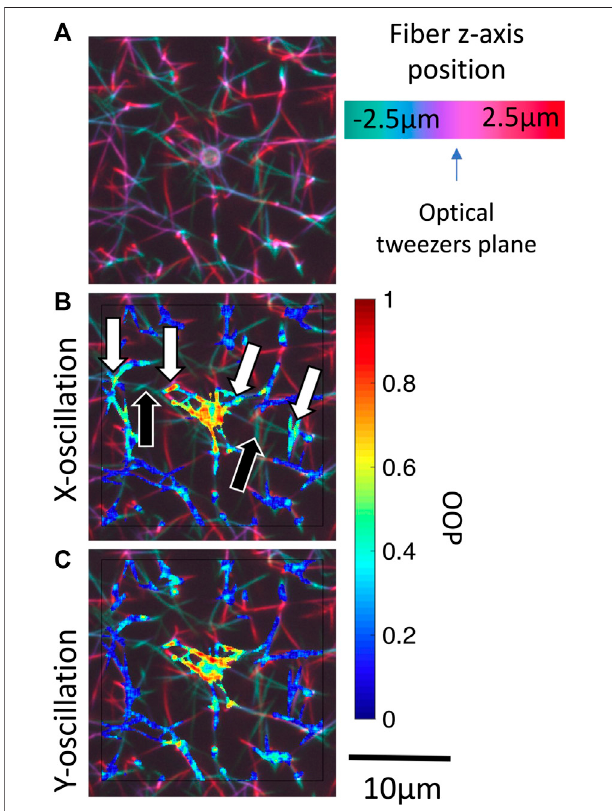
FIGURE 7 | Identi fi cation of potential out-of-plane force transmission pathways. (A) Pseudo color projection is used to encode depth within a 3-D confocal image stack for bead i ( Figure 5 ). Masked local OOP images are superposed onto the depth images for oscillations in the (B) x -direction and (C) y -direction. Black arrows indicate out-of-plane fi bers which may be transmitting forces. White arrows indicate the oscillating fi ber network regions on either side of the out-of-plane fi ber. Supplementary Figure S3 shows OOP overlaid on 3-D confocal image stack for beads i-iv .